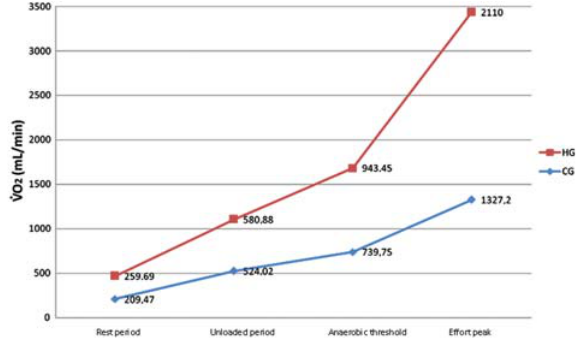
: Figure 1. V O 2 under conditions of rest and effort. V directly obtained by a metabolic analysis system during the CPET in the healthy group (HG) and coronary artery disease group : O 2 : oxygen uptake. (CG). V